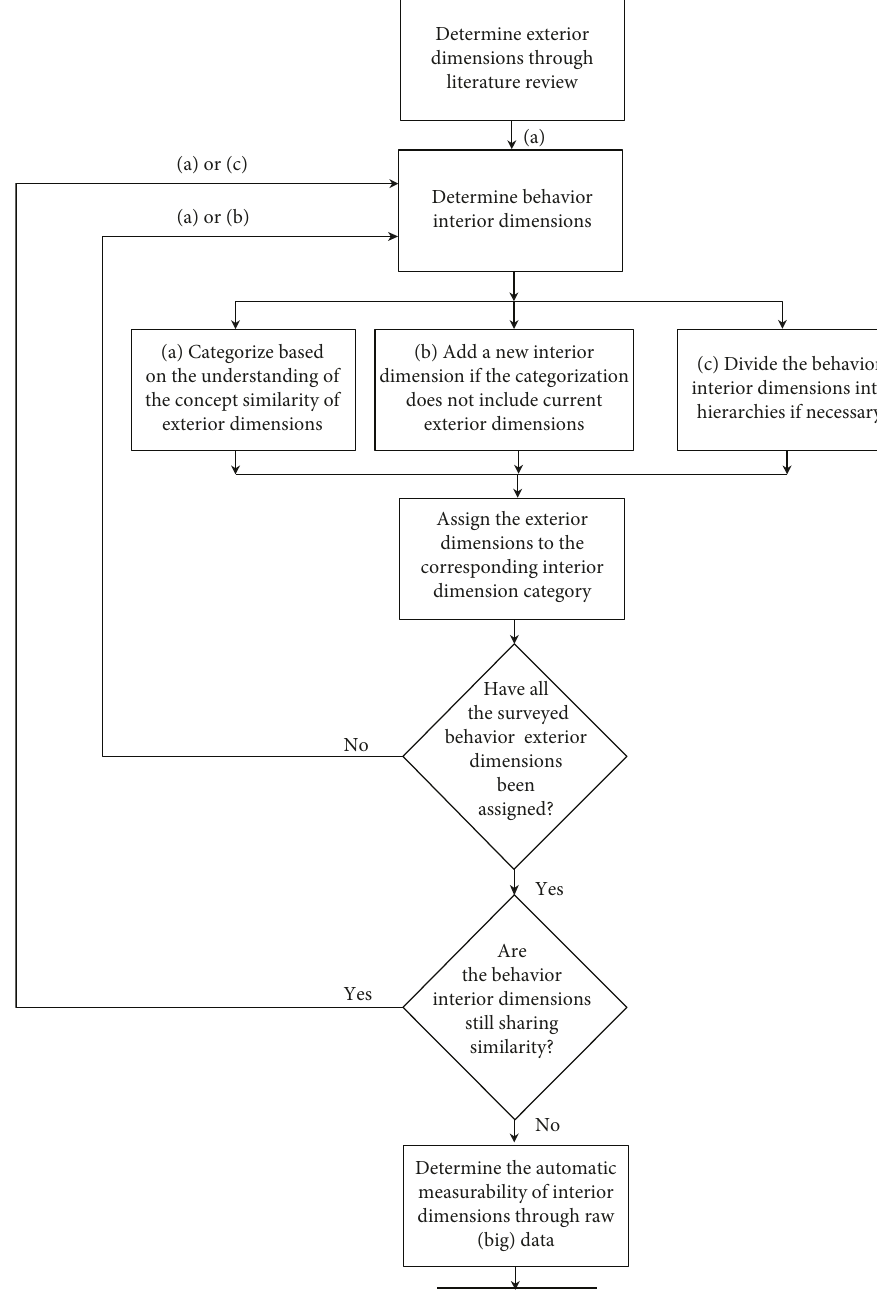
Figure 1: Identi fi cation of behavior interior